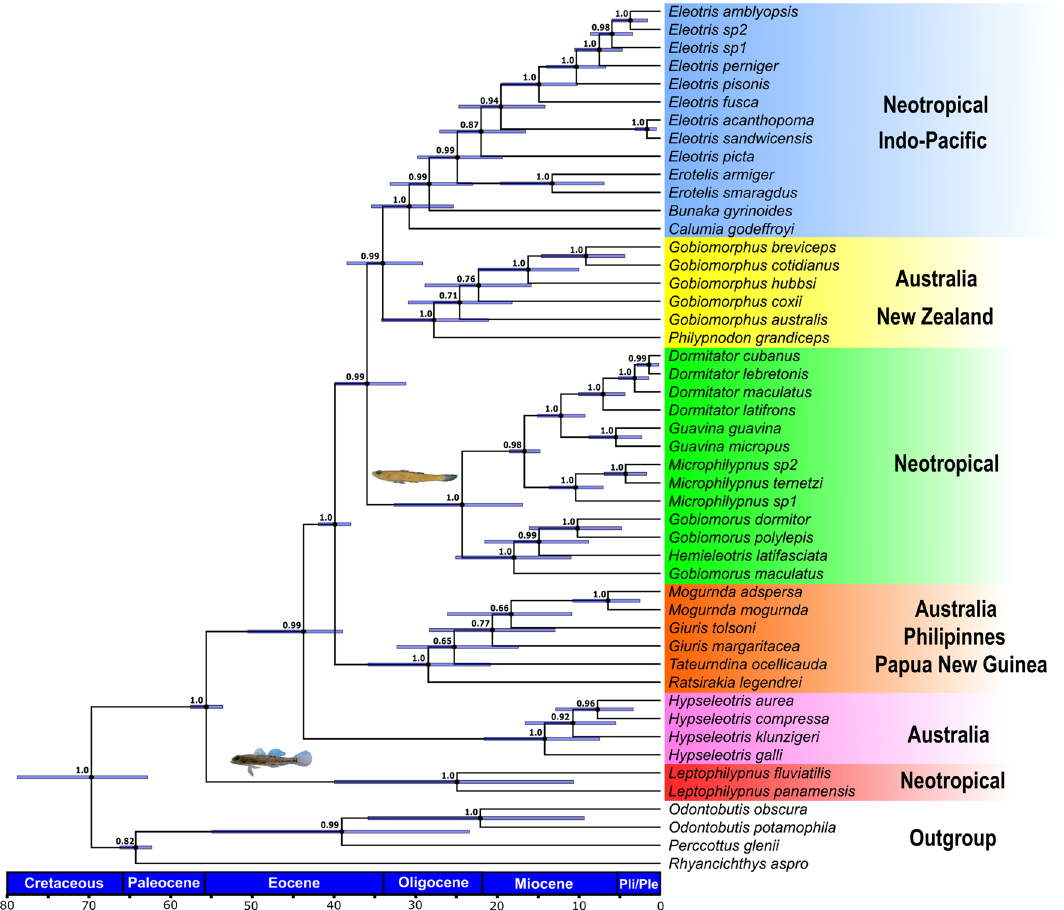
Figure 2. Combined mitochondrial and nuclear DNA species tree based on the algorithm implemented in *BEAST. Blue bars illustrate the 95% highest posterior density of node heights and support values of the posterior probability are displayed on each node. The clade in green shows the phylogenetic position of the miniature lineage of Microphilypnus , while Leptophilypnus (red branch) appears as sister group of other